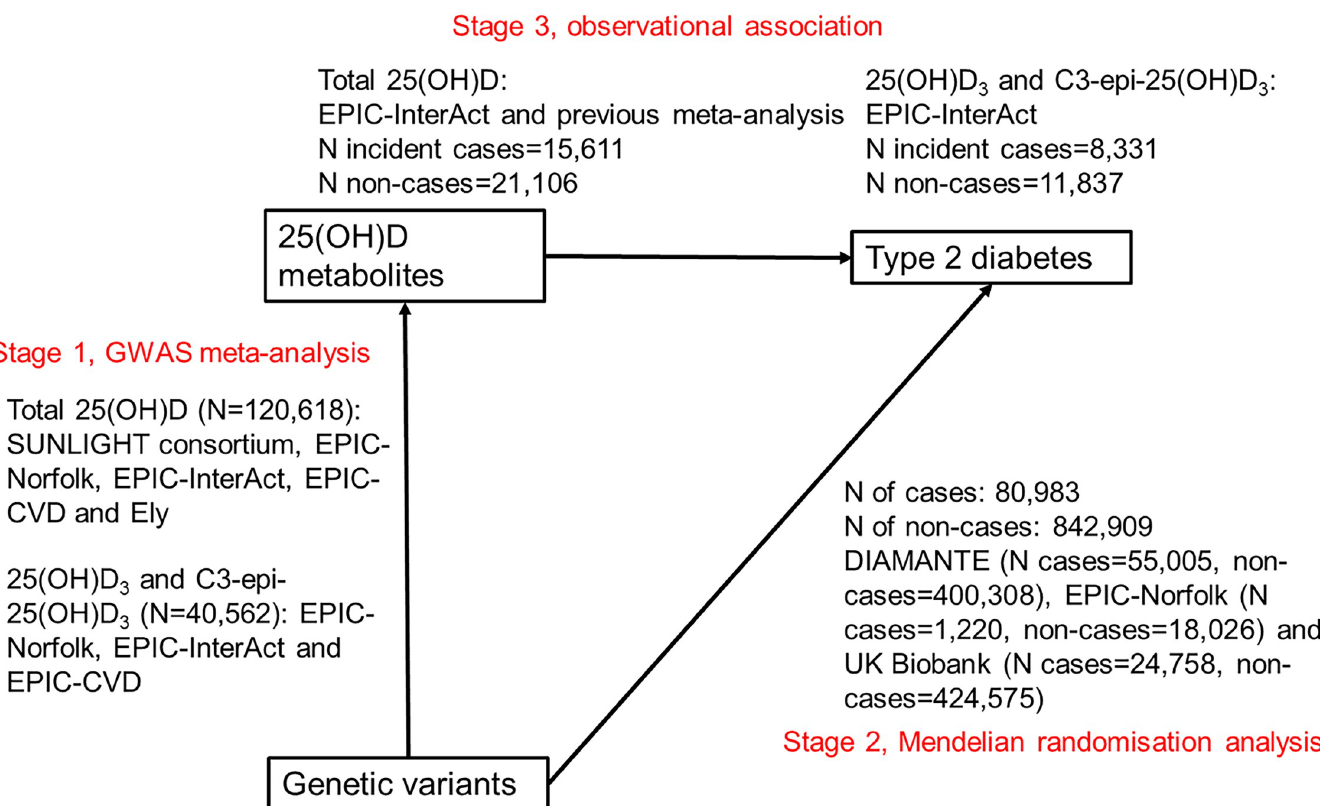
Fig 1. Design of the Mendelian randomisation study to estimate the causal association of 25-hydroxyvitamin D metabolites with type 2 diabetes. 25(OH)D, 25-hydroxyvitamin D; GWAS, genome-wide association study.